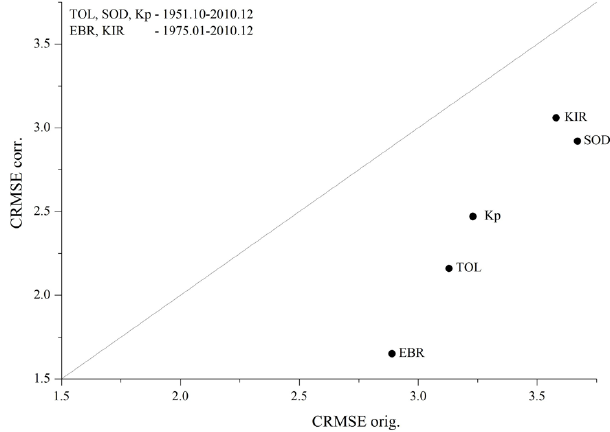
Fig. 5. CRMSE of corrected vs. original COI Ki series.